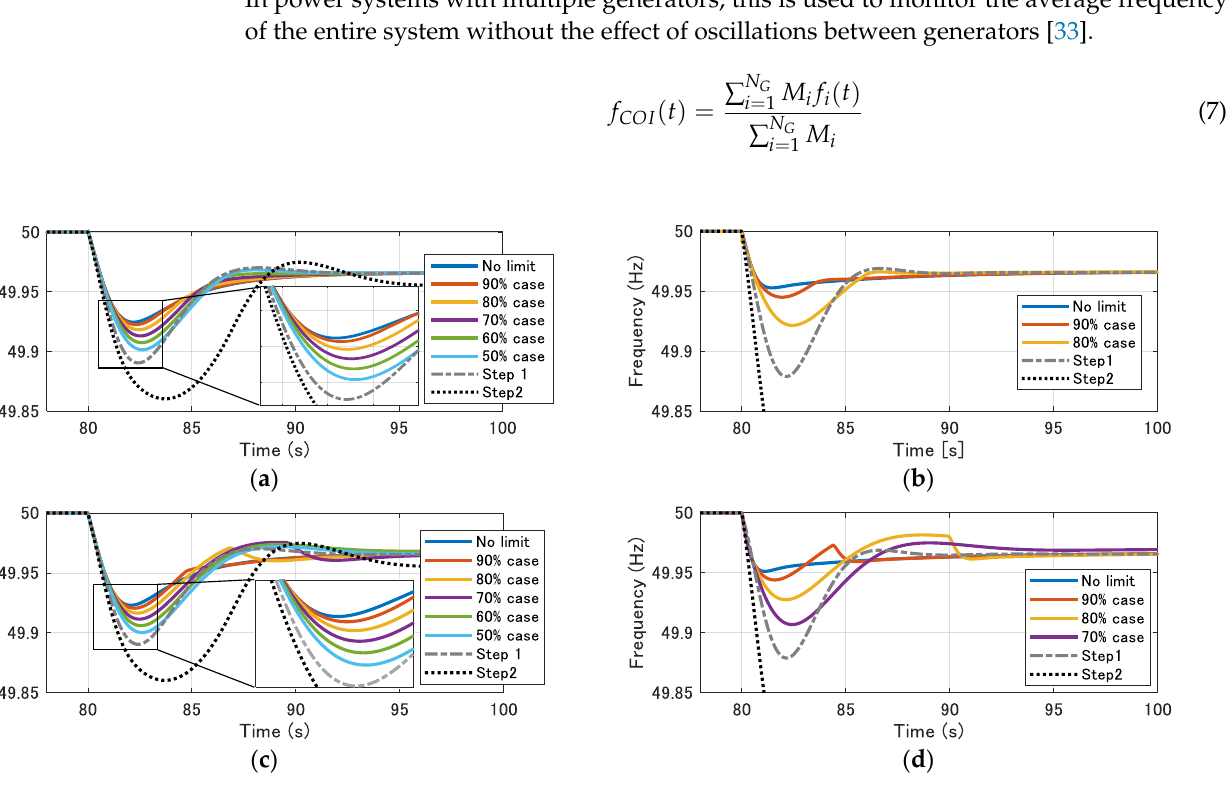
Figure 12. COI frequency. ( a ) #3-GFMpro-L, ( b ) 3-GFMpro-H, ( c ) #3-GFL-L, ( d ) #3-GFL-H.